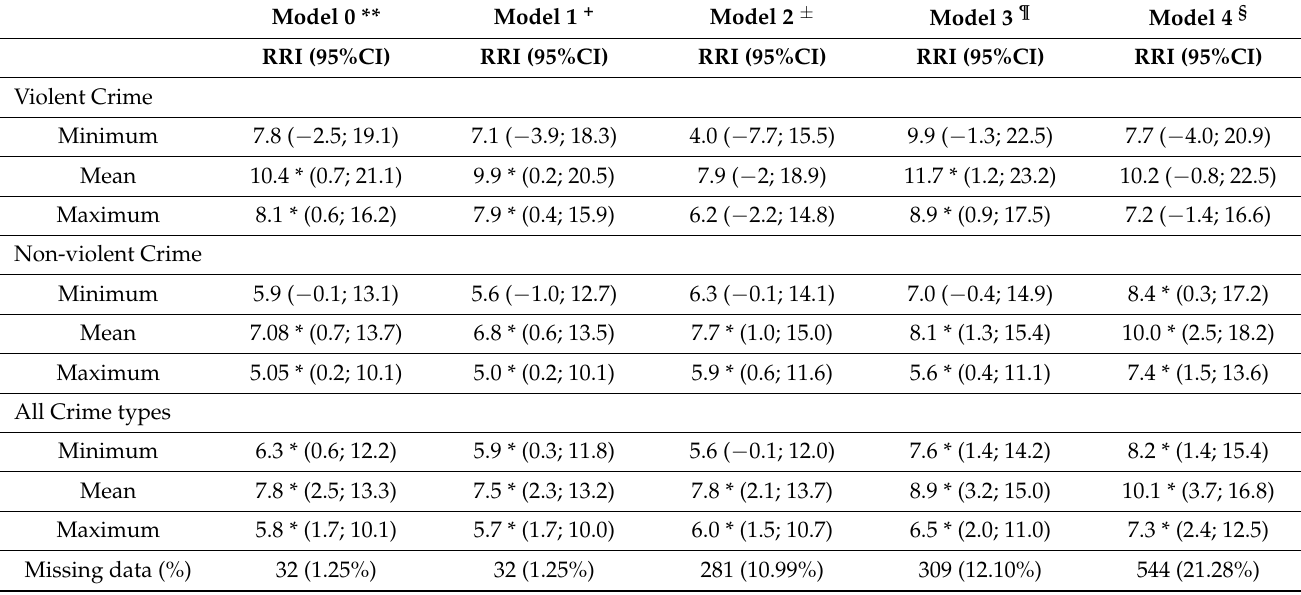
Table 2. Crude and adjusted models of estimated relative risk increase for violent and non-violent crime for each 5 ◦ C increase in daily mean, maximum and minimum temperature on the day of exposure in urban Hanoi, Vietnam, 2013–2019. An asterisk denotes statistically significant estimates ( p <